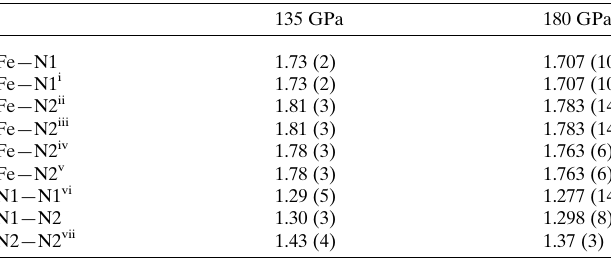
Table 1 Selected bond lengths for FeN 4 at 135 GPa (Bykov et al. , 2018 a ) and at 180 GPa (this study).